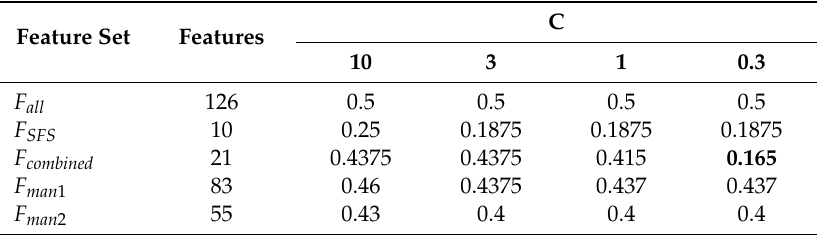
Table 6. Leave-one-out cross-validation (LOOCV) error on di ff erent feature sets and various C values. Feature